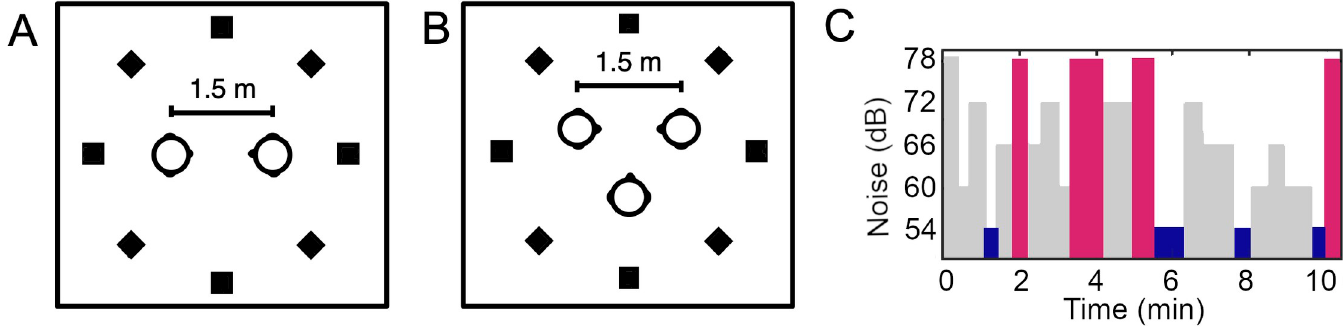
Fig 1. Study setup. (A) shows the positions of loudspeakers and participant chairs for dyads, and (B) shows positions for triads. (C) shows an example of the noise level changes as a function of time (varying between 54, 60, 66, 72, and 78